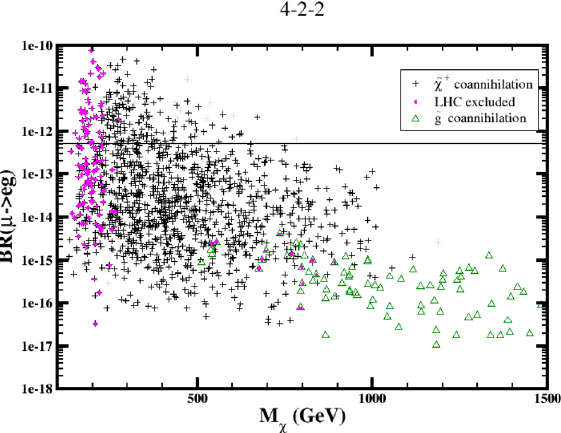
Figure 5 . As in (cid:12)gures 3 and 4 for models with chargino and gluino coannihilations in the 4-2-2